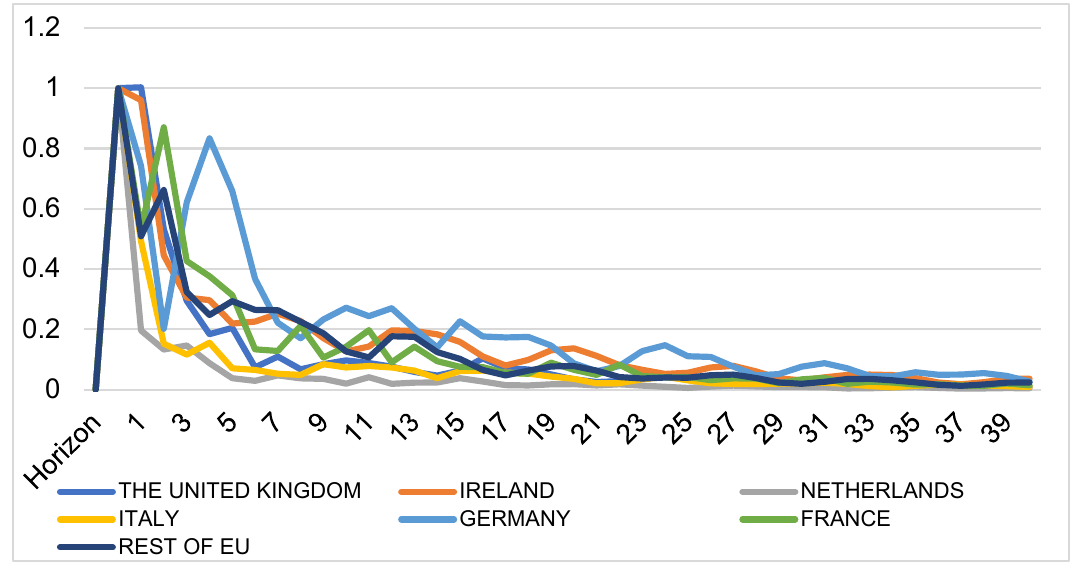
Figure A2 below indicates that the speed of convergence is fast for all countries, so the model is stable over time.